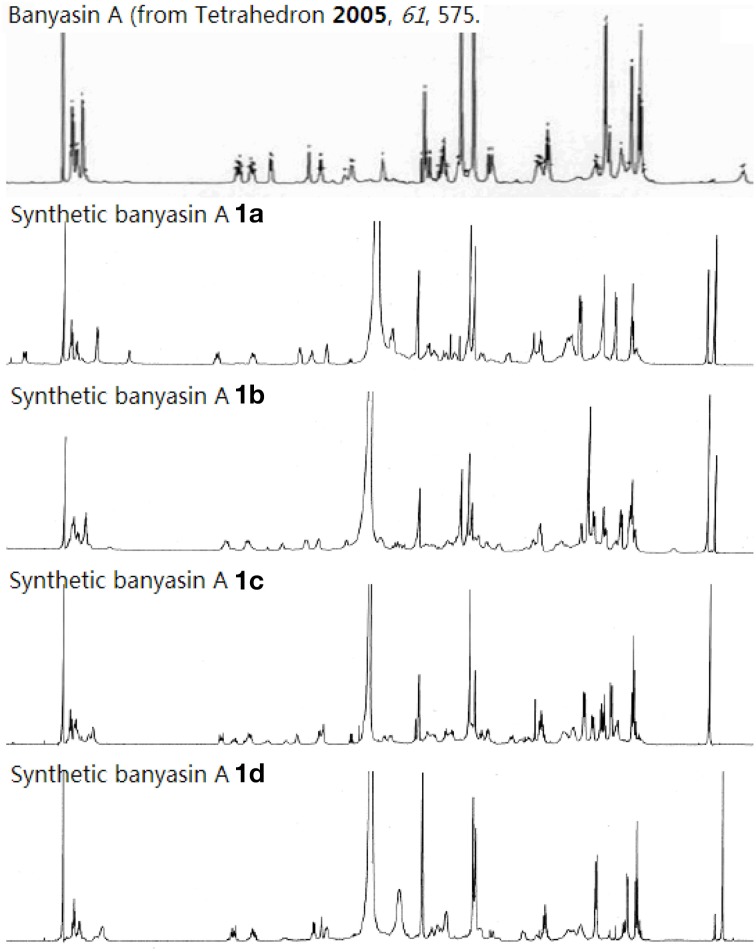
Comparison of 1H NMR of natural and synthetic banyasin A (1a–d).